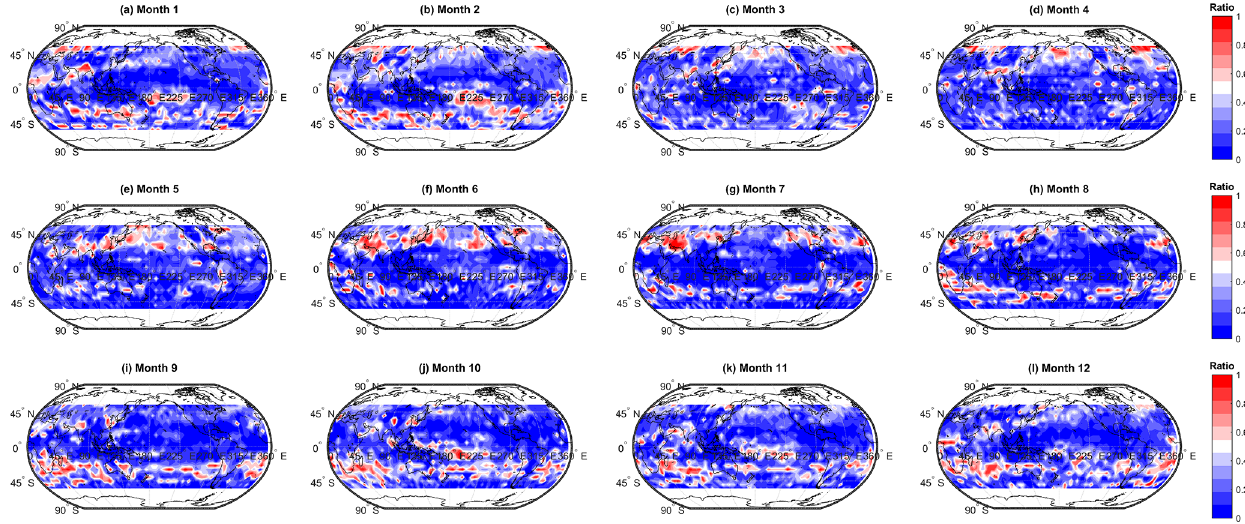
Figure 10. Spatial and temporal variability in the ratio of the number of members in the second most populous cluster (cluster 2) to those in the most populous cluster (cluster 1).